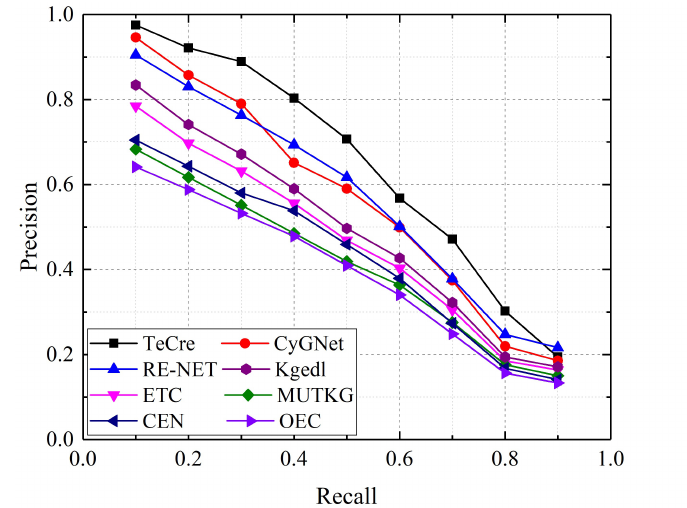
Figure 5. Comparison results on the ICEWS05-15 dataset.